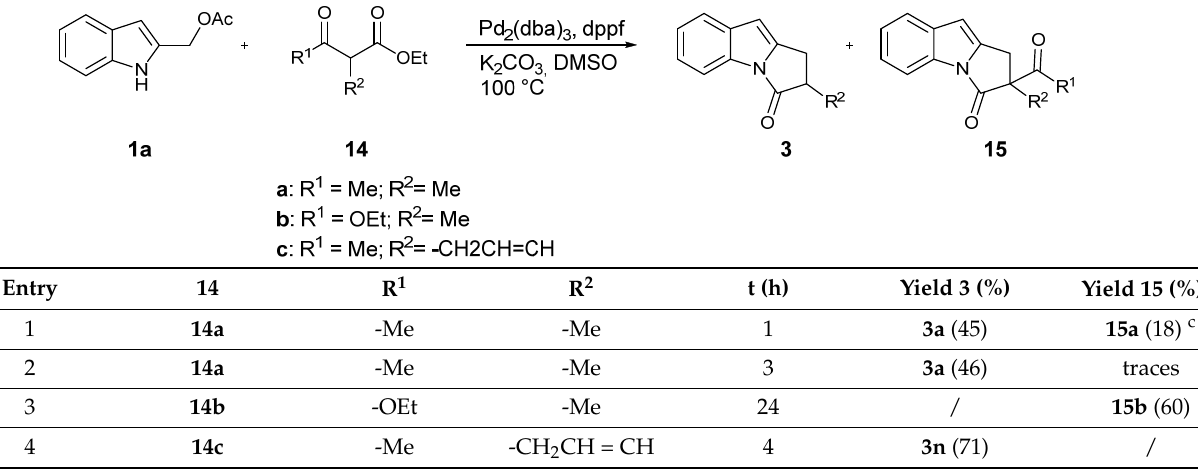
Table 4. Synthesis of 2-substituted 1,2-dihydro-3 H -pyrrolo[1,2- a ]indol-3-one 3/15 from indol-2- ylmethyl acetates 1a and substituted methylene active compound 14 . a